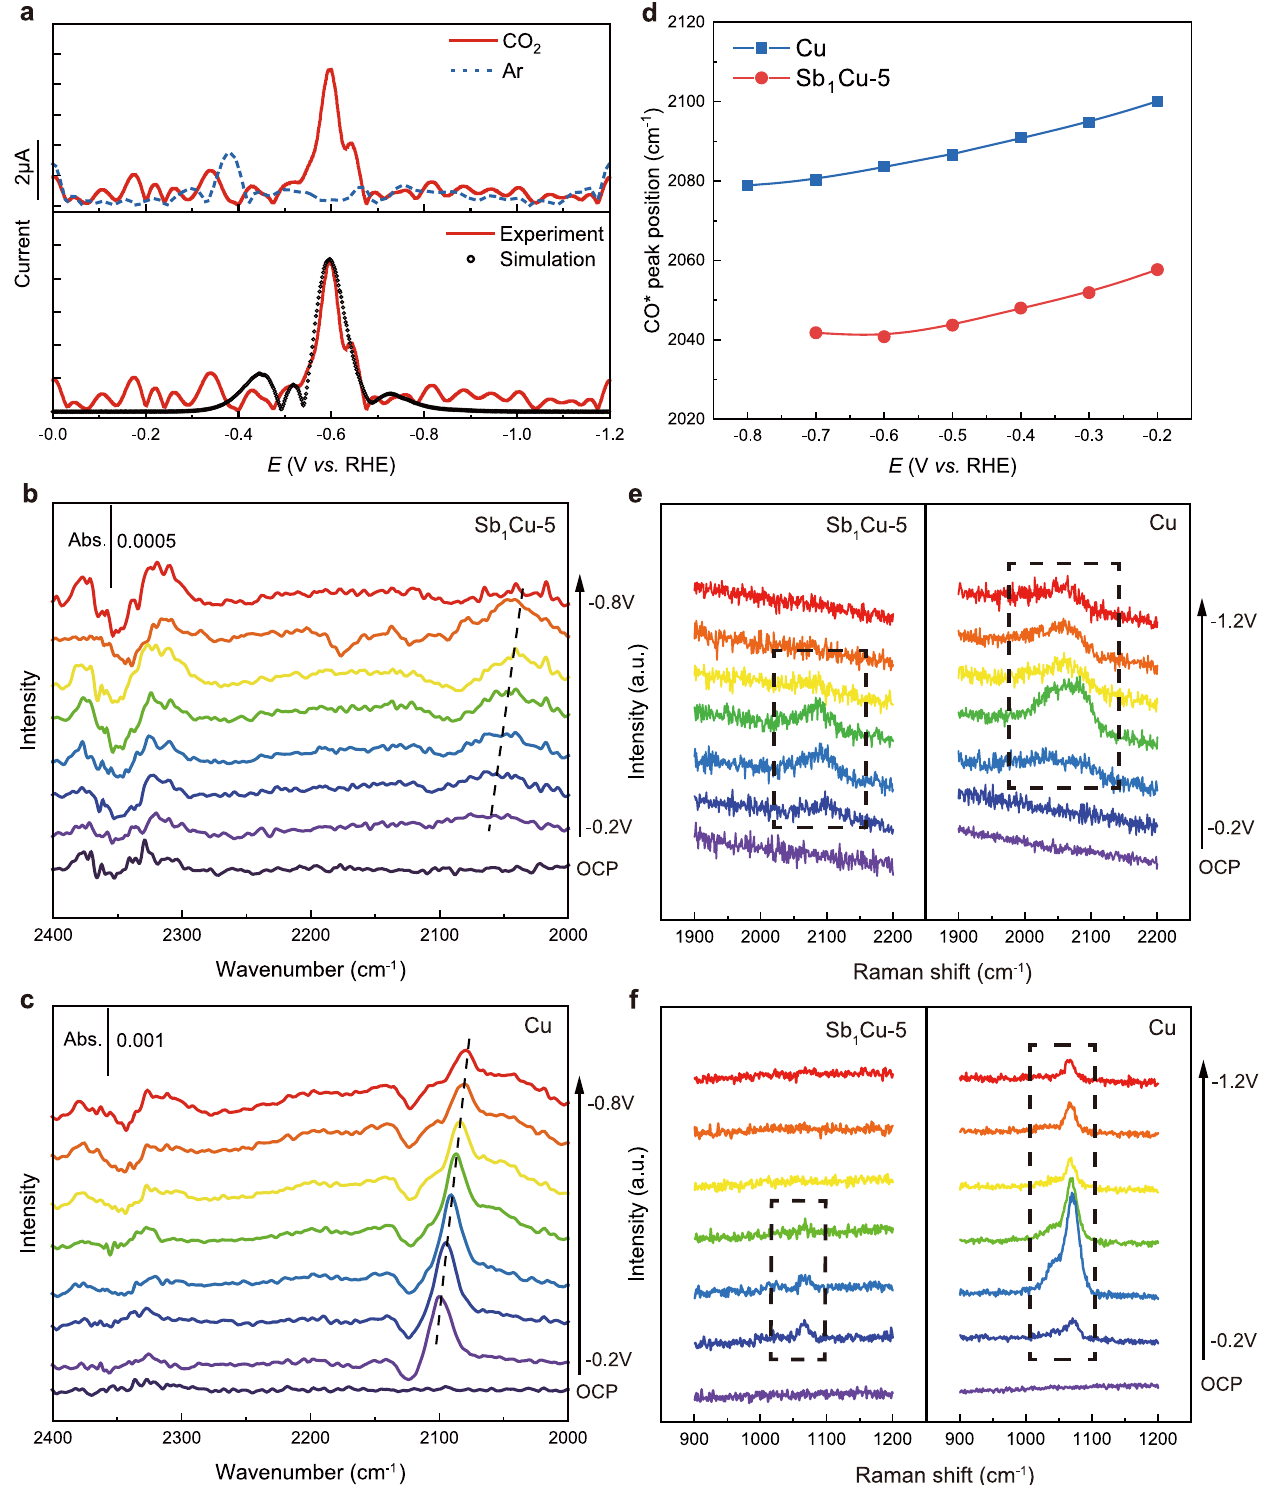
Fig.3|MechanisticstudiesoftheelectrochemicalCO 2 -to-COconversiononthe Sb 1 Cu catalyst. a Fourth harmonic components of FTacV derived on Sb 1 Cu-5 in 0.5M KHCO 3 solution saturated with CO 2 (solid line) and Ar (dashed line). The FTacV parameters are f =9.02Hz, Δ E =80mV, and scan rate=10.57mVs − 1 . The fi tting of the fourth harmonic component is also displayed at the bottom. In situ